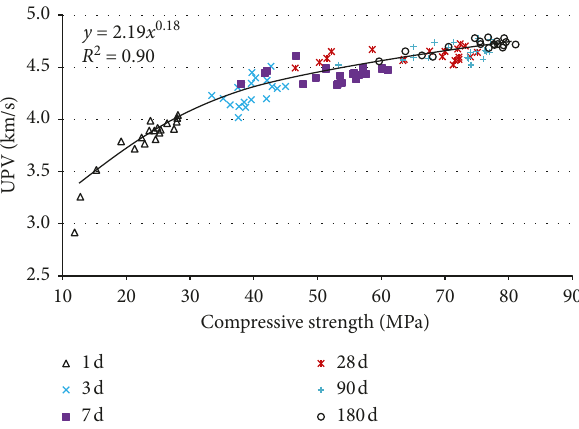
Figure 3: Relationship between compressive strength and UPV